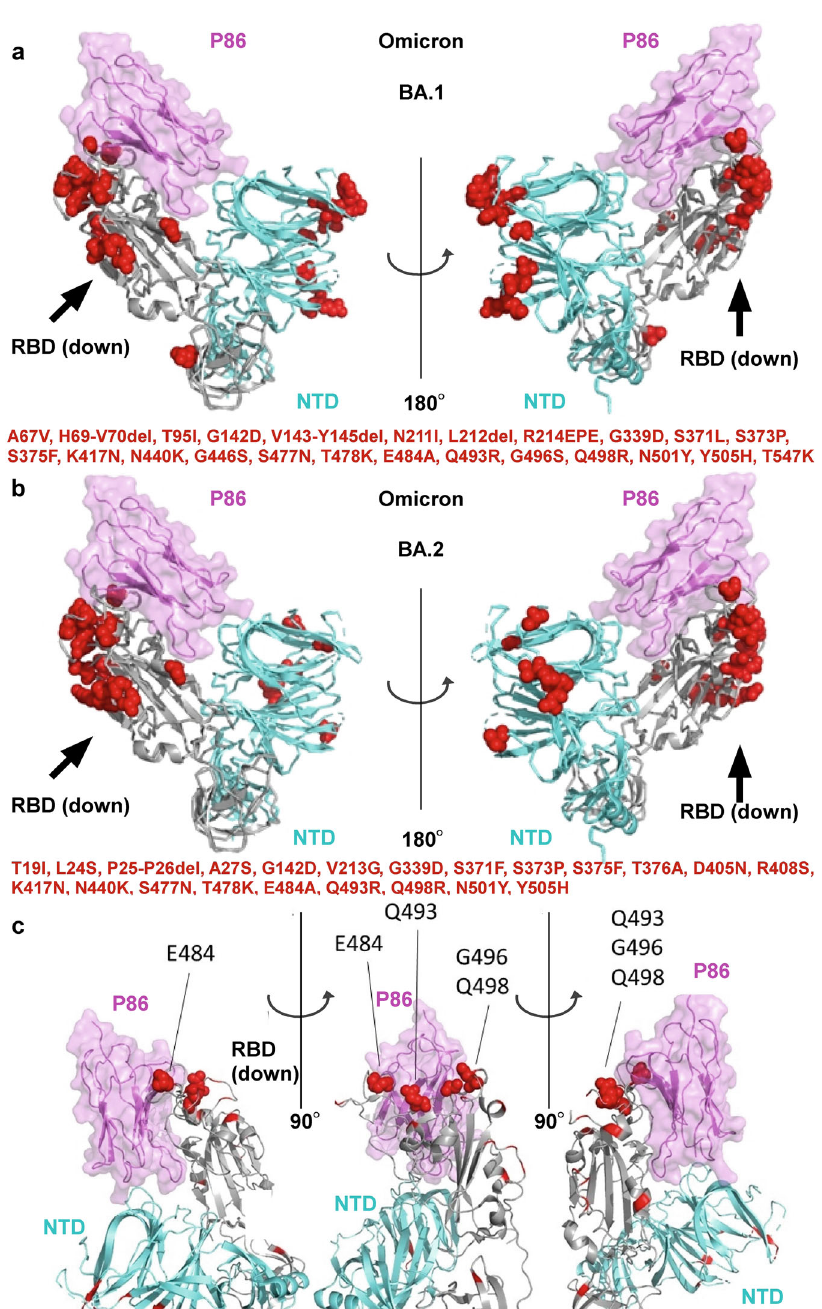
Fig. 7 Fitting the model of P86 with the SARS-CoV-2 Omicron variants. a , b The down-RBD, the neighbouring NTD, and P86 are coloured grey, cyan, and pink, respectively. Spike protein mutations of the SARS-CoV-2 Omicron variants BA.1 ( a , c ) and BA.2 ( b ) are depicted in red. c A close-up view of the binding domain of P86 with the RBD denoting residues E484, Q493, G496 and